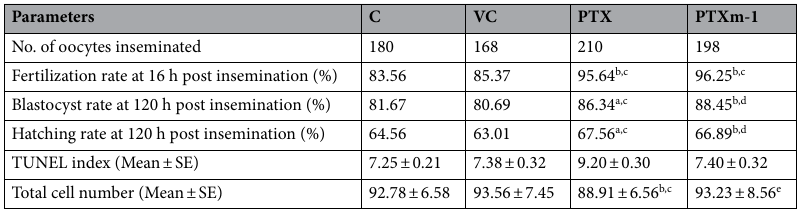
Table 4. Effect of PTX and PTXm-1 on the in vitro fertilization and embryo development potential in Swiss albino mice. The error value represents standard error to mean. C, control; VC, vehicle control; PTX, pentoxifylline; PTXm-1, modified pentoxifylline. a P < 0.05, b P < 0.01 compared to control; c P < 0.05, d P < 0.01 compared to vehicle control; e P < 0.05 compared to